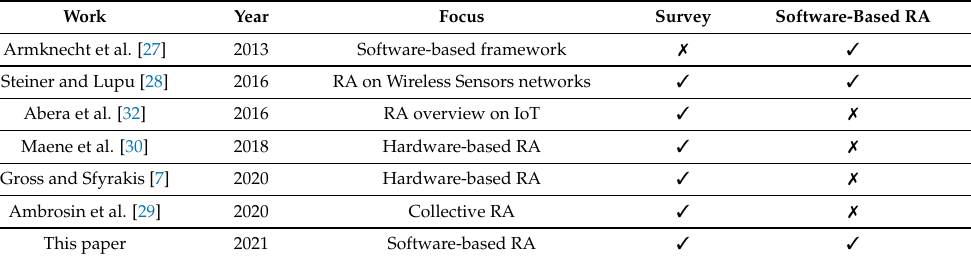
Table 1. Related work